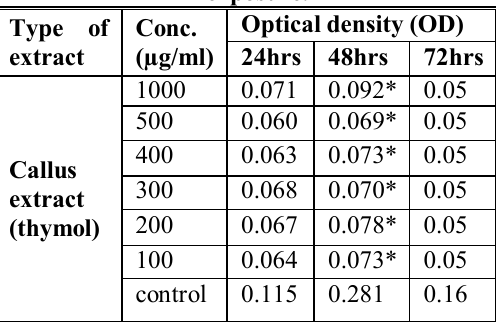
Table 1: A comparison optical density of growth inhibition of Hep-2 cell line, by using different concentration of callus extracts of Nigella sativa during three periods of exposure.